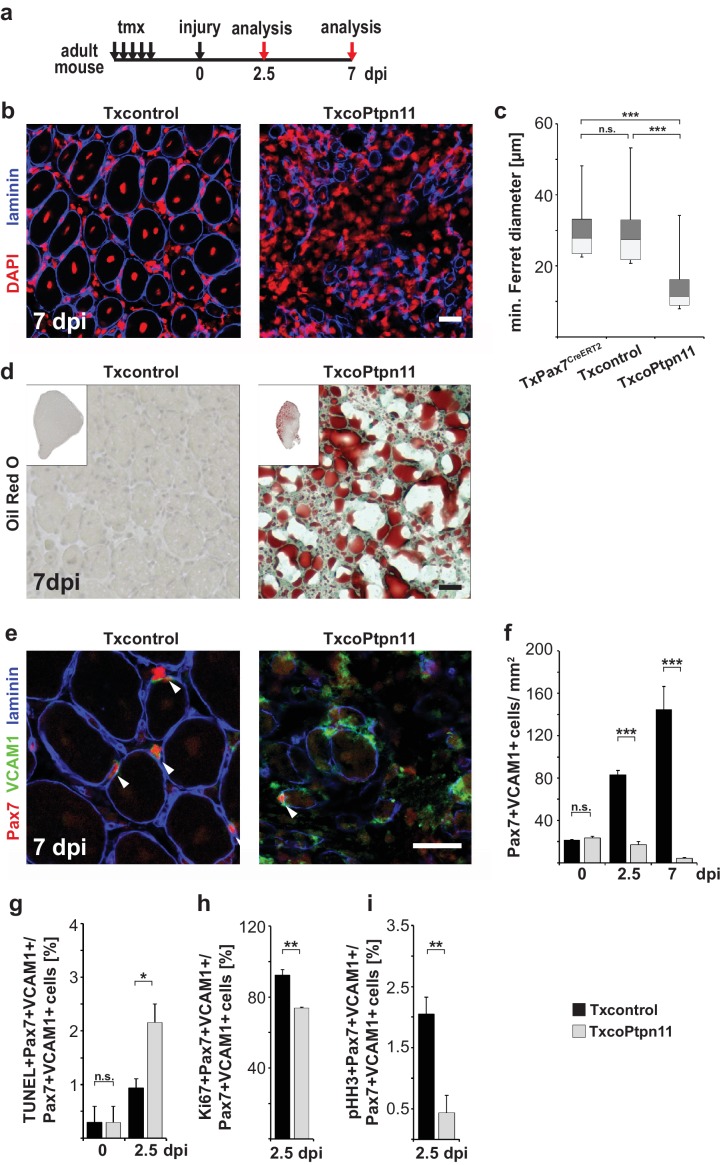
Ptpn11 is essential for skeletal muscle repair.(a) Outline of the regeneration experiment. (b) Immunostaining for laminin (blue) of injured muscle from Txcontrol and TxcoPtpn11 animals seven days after injury (7dpi). Nuclei were counterstained with DAPI (red). (c) Box plot showing the quartile distribution and minima/maxima of the diameters of regenerating fibers. (d) Oil Red O staining of regenerating muscle seven days after injury. (e) Immunohistochemical analysis using antibodies for Pax7 (red), VCAM1 (green) and laminin (blue) of muscle after injury; arrowheads point towards Pax7+VCAM1+ cells. (f) Quantification of Pax7+VCAM1+ cells/mm2 before injury, as well as 2.5 and 7 days after injury. (g) Quantification of Pax7+VCAM1+TUNEL+ positive cells before and 2.5 days after muscle injury. (h, i) Quantification of Pax7+VCAM1+ cells co-expressing Ki67 (h) or phospho-Histone H3 (pHH3) (i) 2.5 days after injury. n.s. = not significant, *p<0.05, **p<0.01, ***p<0.001. Error bars show S.E.M. Scale bar: 25 µm.